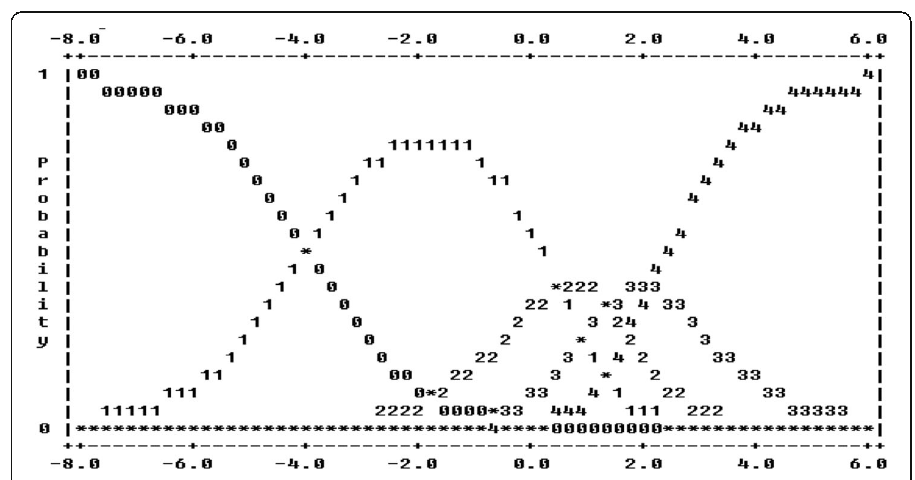
Fig. 4 Probability curves for Source